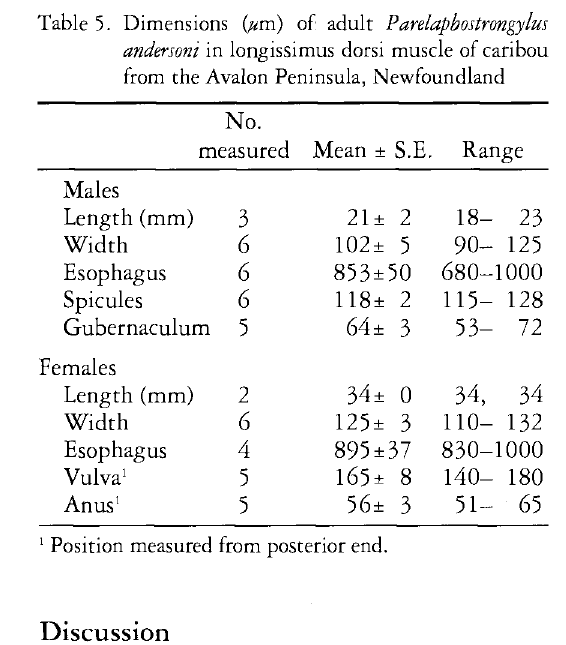
andersoni in longissimus dorsi muscle of caribou from the Avalon Peninsula, Newfoundland